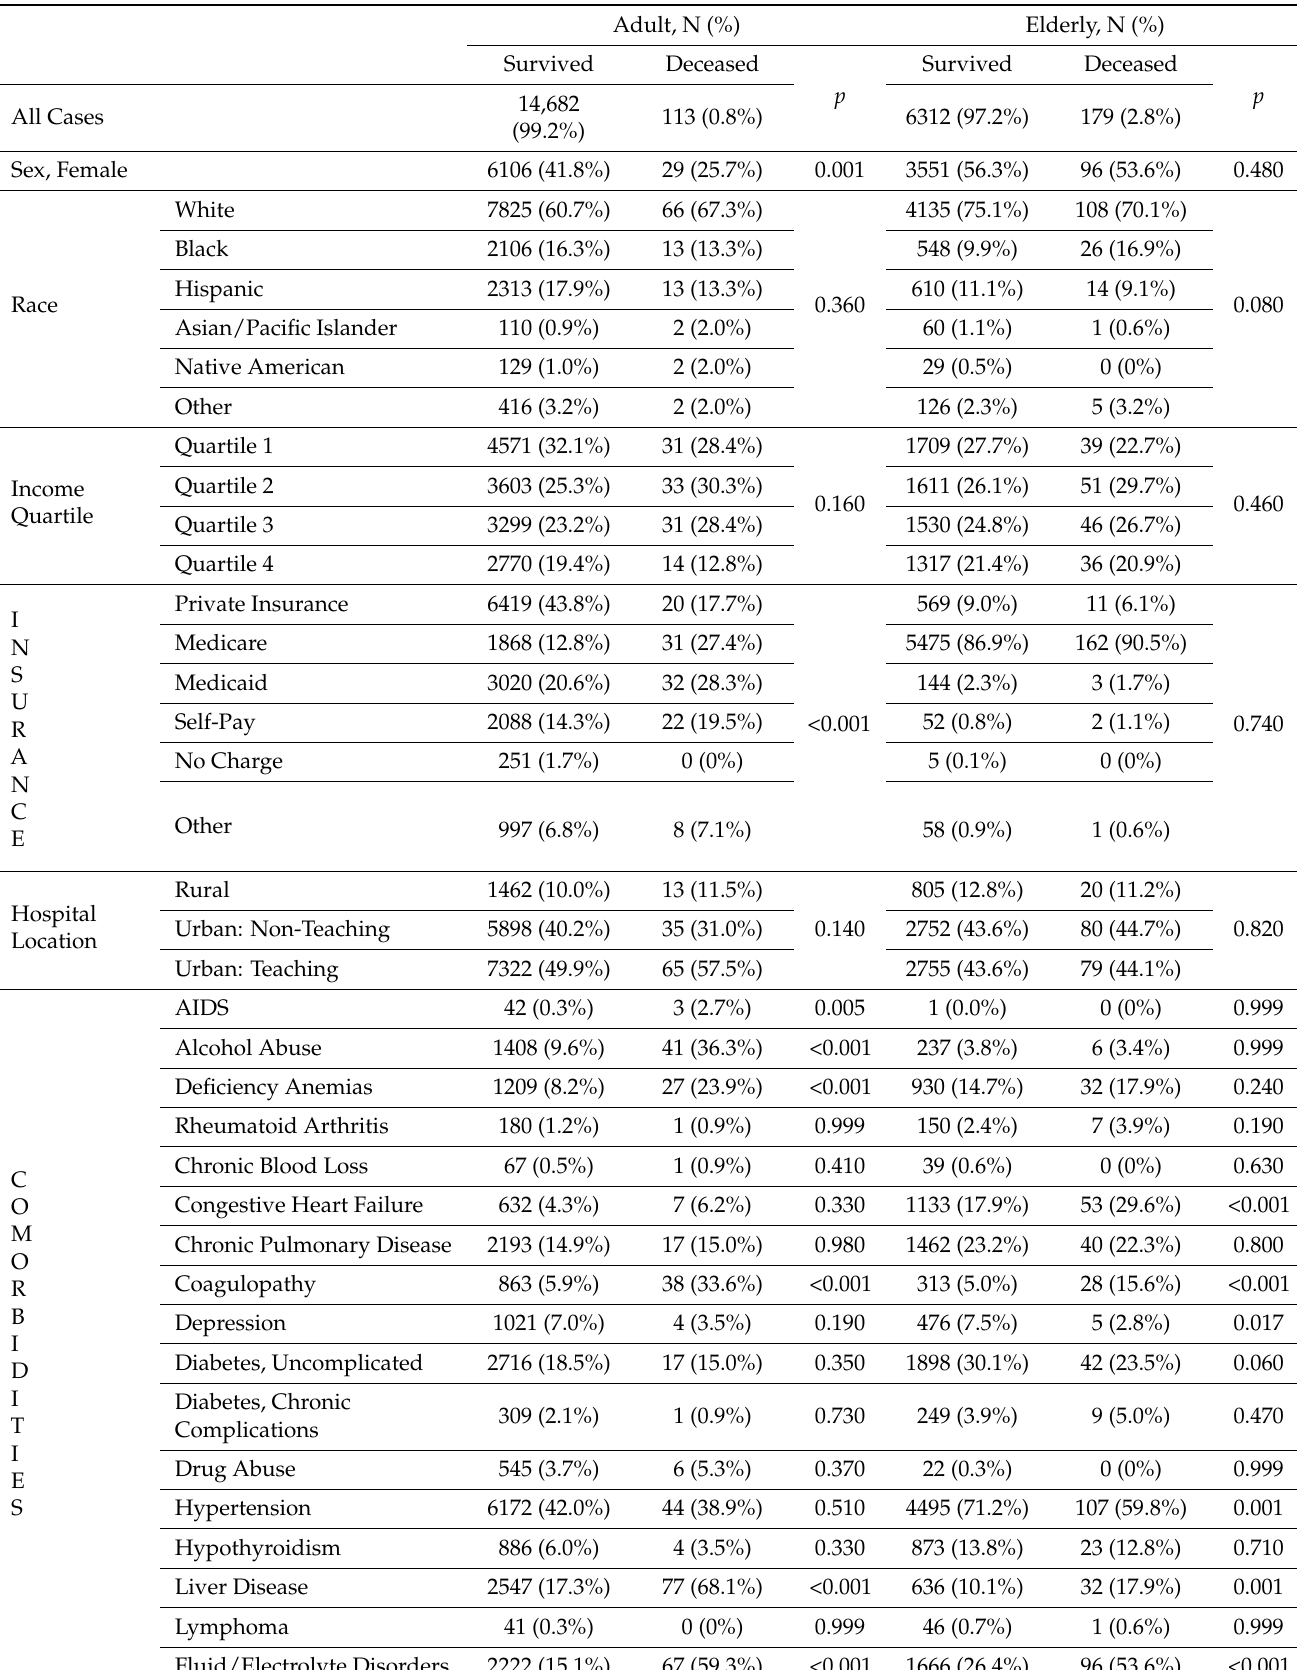
Table 3. Characteristics of emergently admitted patients with the primary diagnosis of umbilical hernia. Data were classified according to outcome categories, NIS